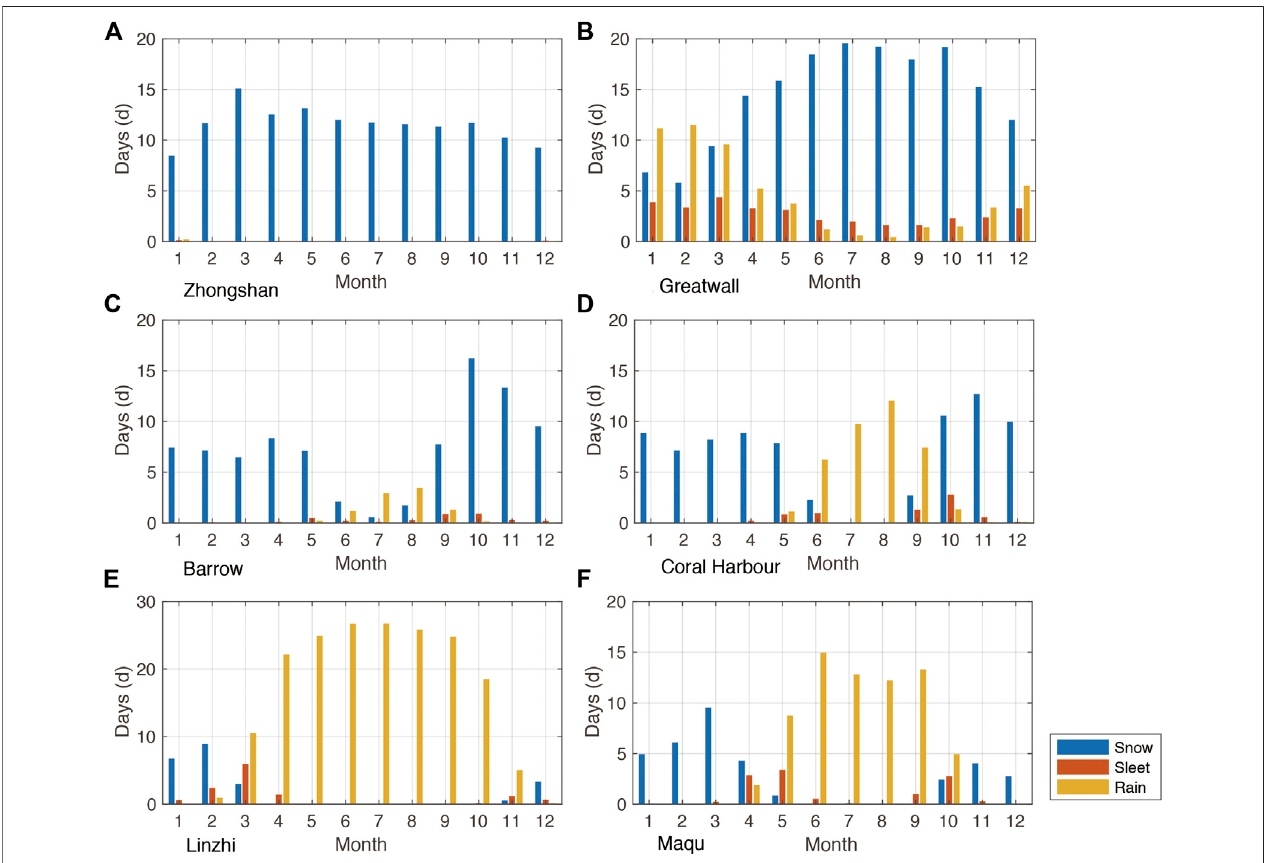
FIGURE2| Monthlyvariationsinsnow,sleetandraindaysattheZhongshan,Greatwall,Barrow,CoralHarbour,LinzhiandMaqustations(a – e:1990 – 2017;f:1997 – 2017).